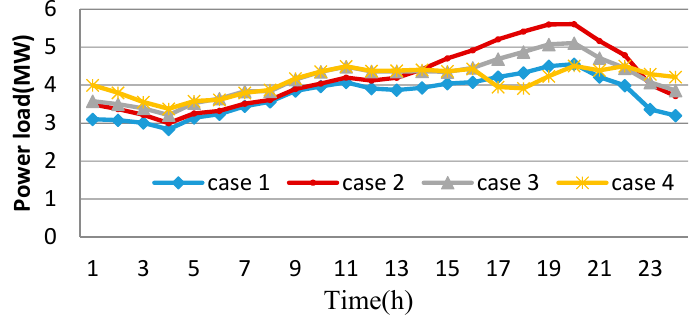
Figure 5. The charging/ discharging load profiles of 1000 EVs. ( a ) Case 2; ( b ) Case 3; ( c ) Case 4.